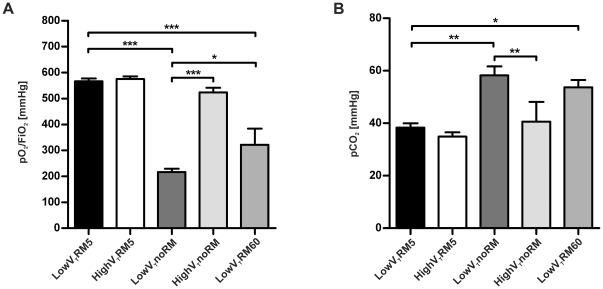
Blood gas results.Arterial blood was analysed after six hours of ventilation. A. pO2/FiO2 ratio was calculated, FiO2 was 0.5. B. Comparison of pCO2 levels. (LowVTRM5 n = 6, highVTRM5 n = 6, lowVTnoRM n = 5, highVTnoRM n = 4, lowVTRM60 n = 5). * p<0.05, ** p<0.01, *** p<0.001.